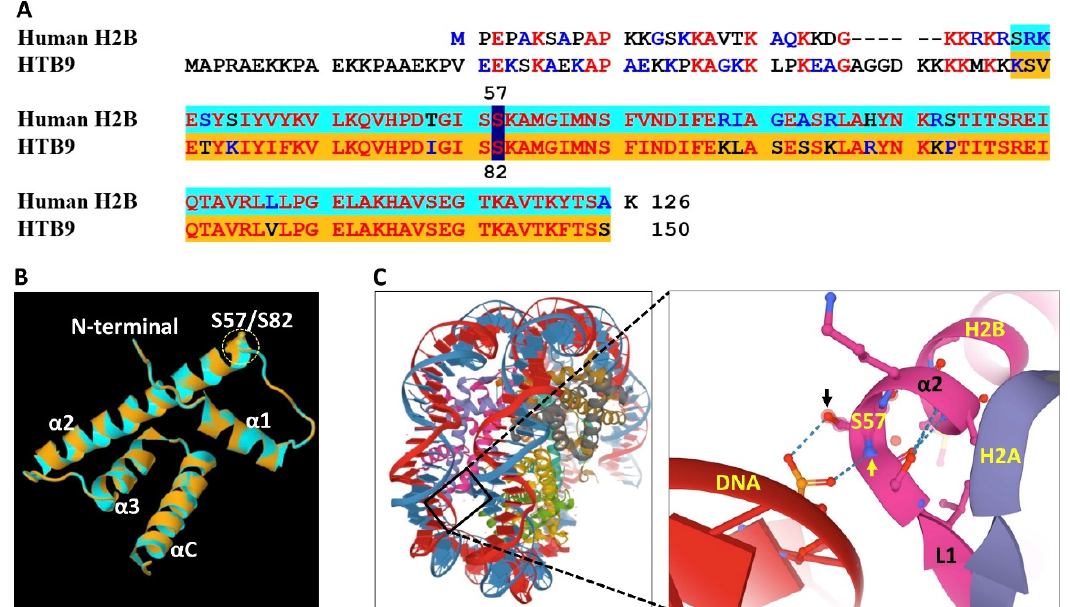
Figure 2. Comparison of H2B protein structure between human and Arabidopsis . ( A ) Alignment of amino acid sequences of H2B from human (H2B type 1-J) and Arabidopsis (HTB9). Histone fold segments used for structure comparison are highlighted in turquoise (human) and orange ( Arabidopsis ). Serine residue S57 (human) or S82 ( Arabidopsis ) is highlighted in dark blue. ( B ) Structural alignment of the core region of H2B from human (Turquoise) and Arabidopsis (orange). The protein structure of the histone fold segment of HTB9 was modeled in SWISS-MODEL (https: // swissmodel.expasy.org / ) using human H2B (PDB ID: 3AV1) as a template, and the predicted structure was aligned with the Arabidopsis HTB9 using RCSB PDB Protein Comparison Tool (http: // www.rcsb.org / pdb / workbench / workbench.do?action = menu). The position of serine S57 / S82 is indicated at the beginning of alpha helix-2 ( α 2). ( C ) Crystal structure of human nucleosome core particle (PDB ID: 3AV1) [35]. A close-up indicates an interaction of H2B with Phosphate group of the DNA via hydrogen bonds made from main-chain amide nitrogen atom (yellow arrow) as well as side-chain hydroxyl oxygen atom (black arrow) of Serine S57. Note, H2B is shown in pink, H2A in purple and the DNA phosphate backbone is shown in red. Loop 1 (L1) and α helix 2 ( α 2) are